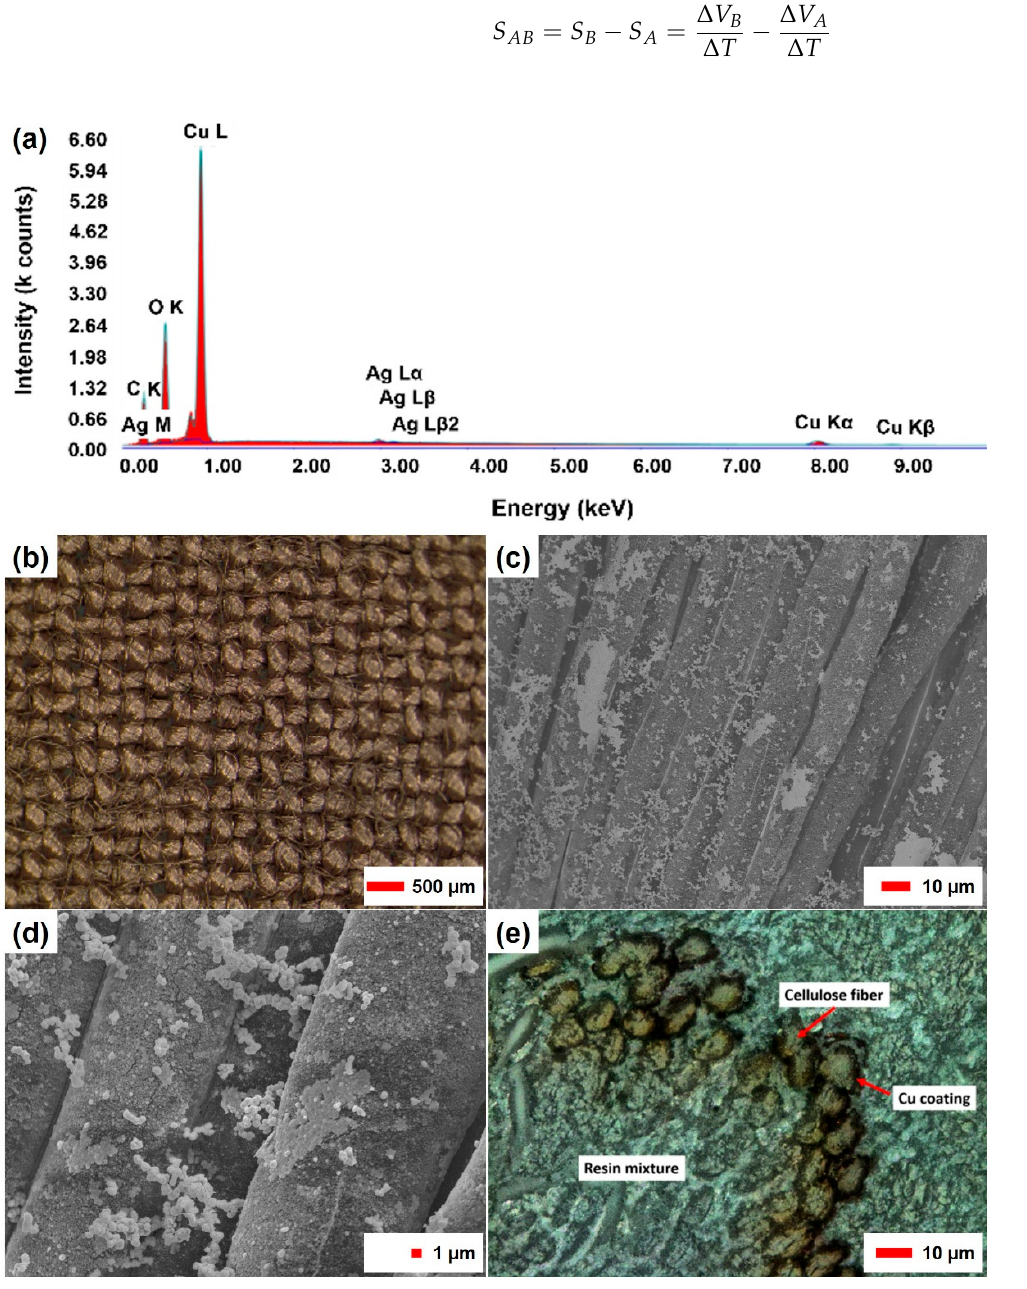
Figure 2. Characterization of the surface of copper-coated lyocell fabrics. ( a ) Shows the result of EDX measurements showing large amounts of copper deposited on the fiber material, ( b ) optical microscopy shows uniform copper deposition, and ( c , d ) scanning electron microscopy shows the growth of different formations on the surface. Image ( e ) shows a laser scanning microscopy image of a cross-section, which indicates that almost 50% of the fibers of one yarn are coated with copper.